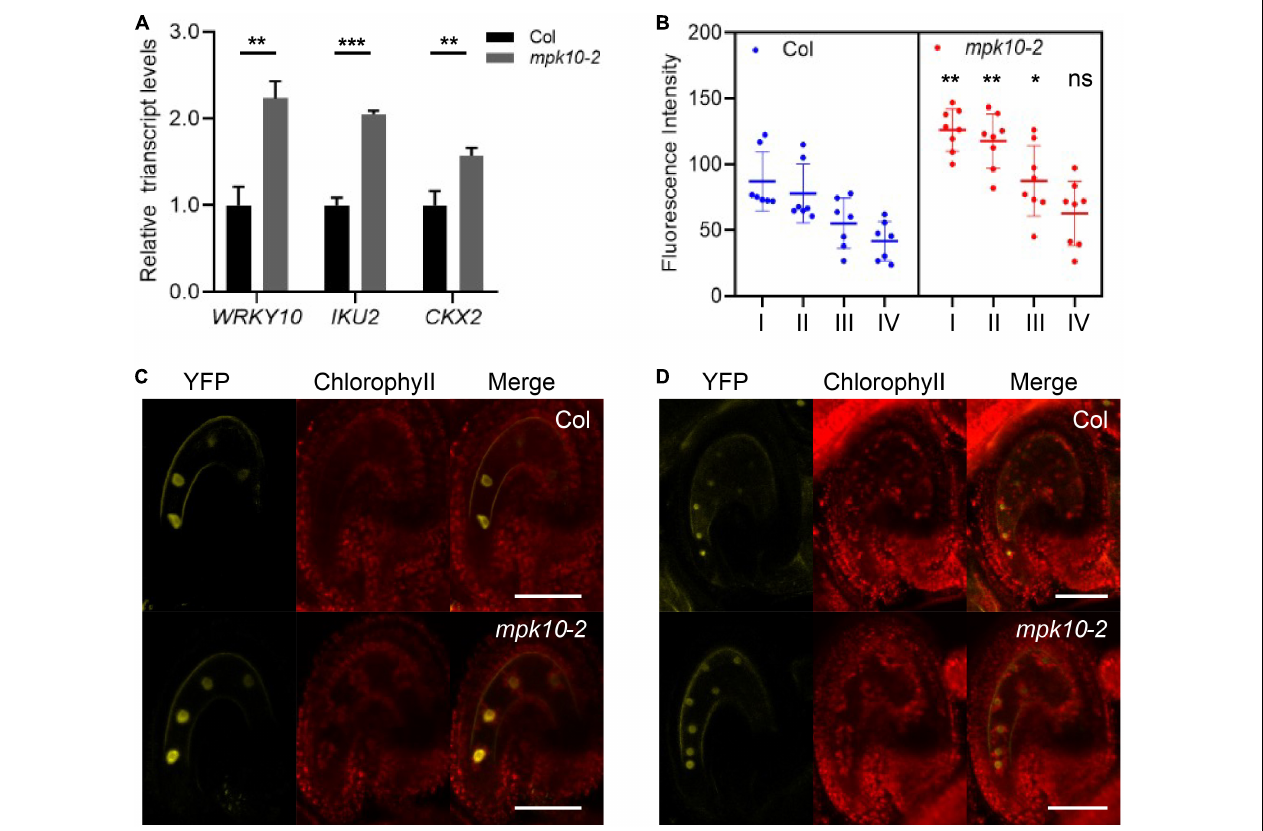
FIGURE 3 | MPK10 suppresses the expression of WRKY10 . (A) The expression of WRKY10 , IKU2 , and CKX2 is increased in mpk10 seeds (2DAP). The RPL5B was used in real-time PCR analysis as an internal standard. (B) The YFP signal is strong in mpk10 mutant compared to that in wild type seeds at 4-nucleuate endosperm stage. The significance analysis was done using the blue dots and the corresponding red dots of I, II, III, VI, and the roman numbers on the X -axis indicate the four nuclei consecutively from micropylar to chalazal. (C, D) Examples of seeds at 4-nucleuate endosperm stage (C) and eight-nucleuate endosperm stage (D) . BF, bright field, YFP, proWRKY10: (cid:127) -WRKY10-YFP . Data present the means ± SD, n = 3. The statistical significances are determined using student’s t -test. * P < 0.05, ** P < 0.01, *** P < 0.001, ns, no significance. Bar = 50 µ m.